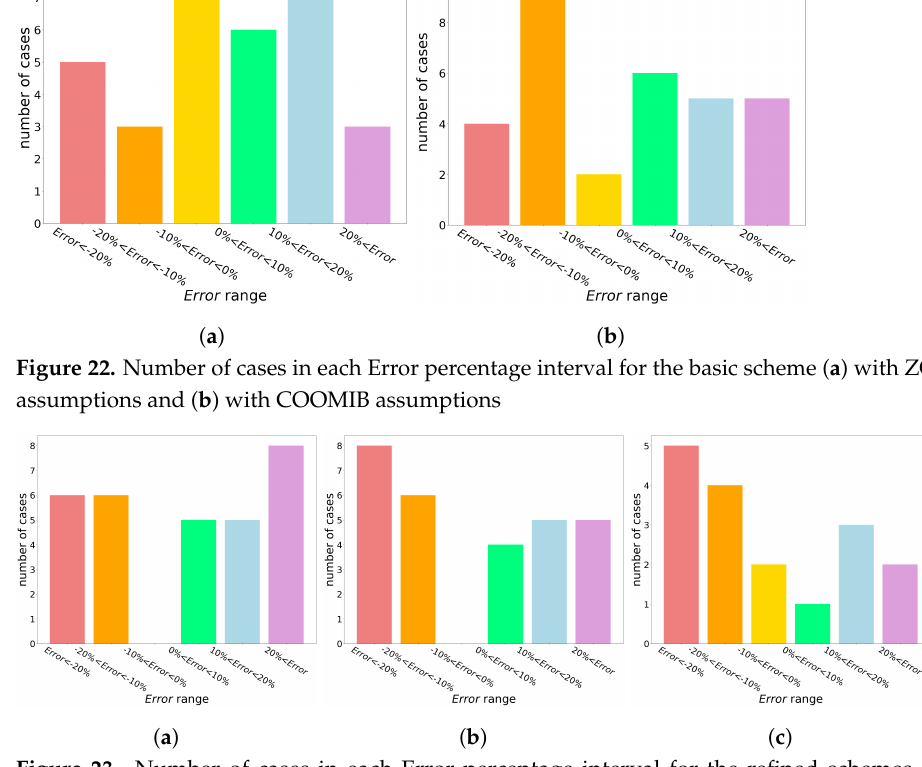
Figure 23. Number of cases in each Error percentage interval for the refined schemes ( a ) first